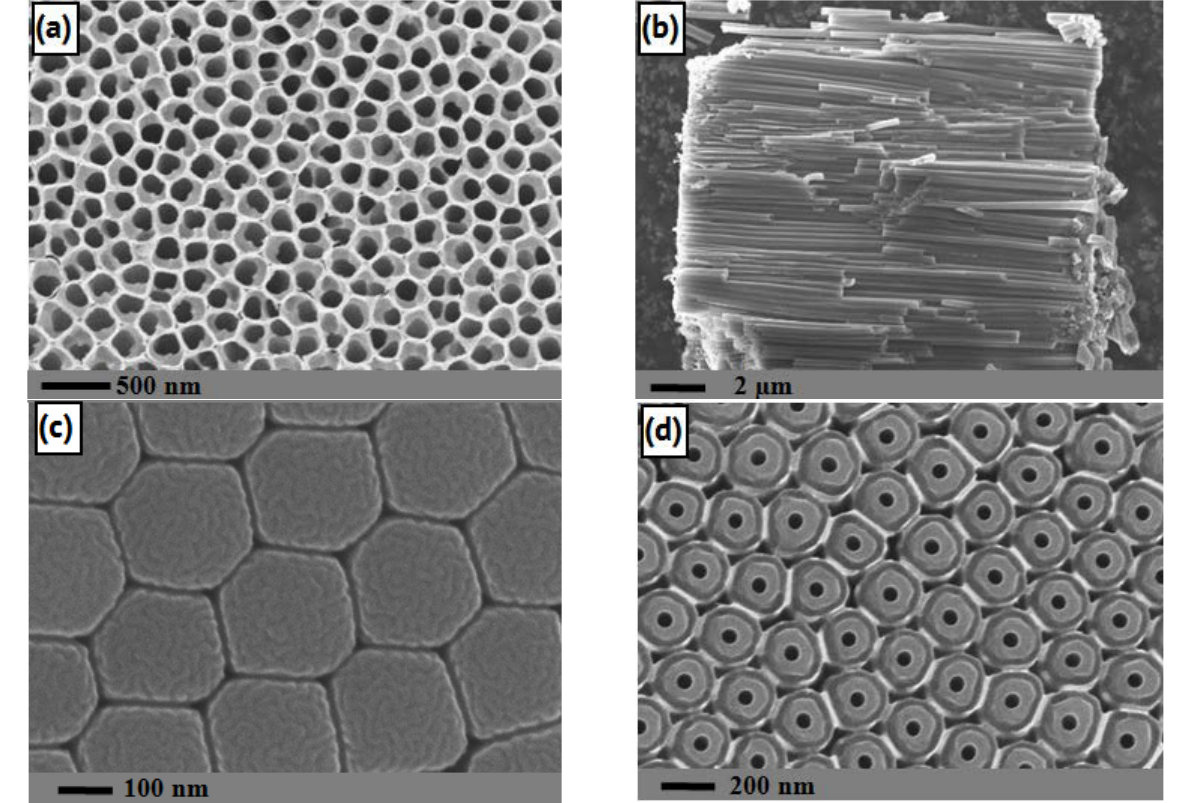
membrane: (a) top part, (b) side view, (c) bottom part before Figure 1. SEM images of TiO 2 dry etching step, (d) bottom part after dry etching showing opened nanotubes.